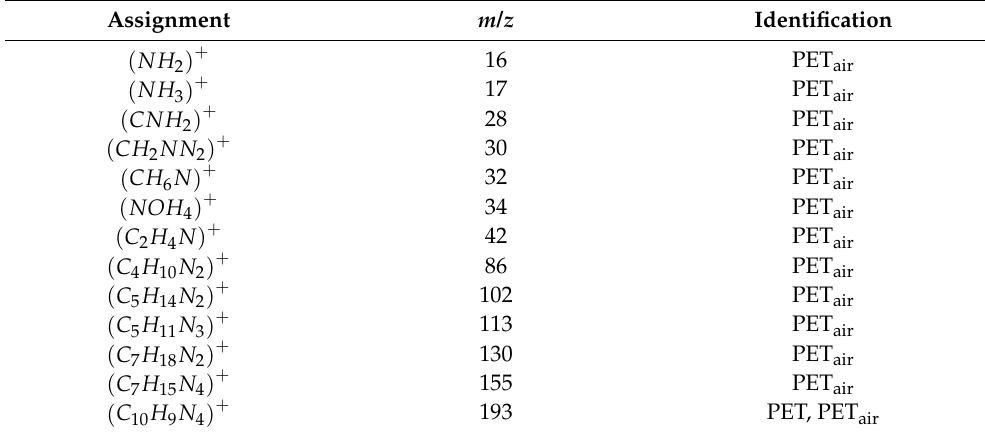
Table 3. Peaks identified for the PET and PET air surfaces in the positive TOF-SIMS mass spectra. Assignment m / z